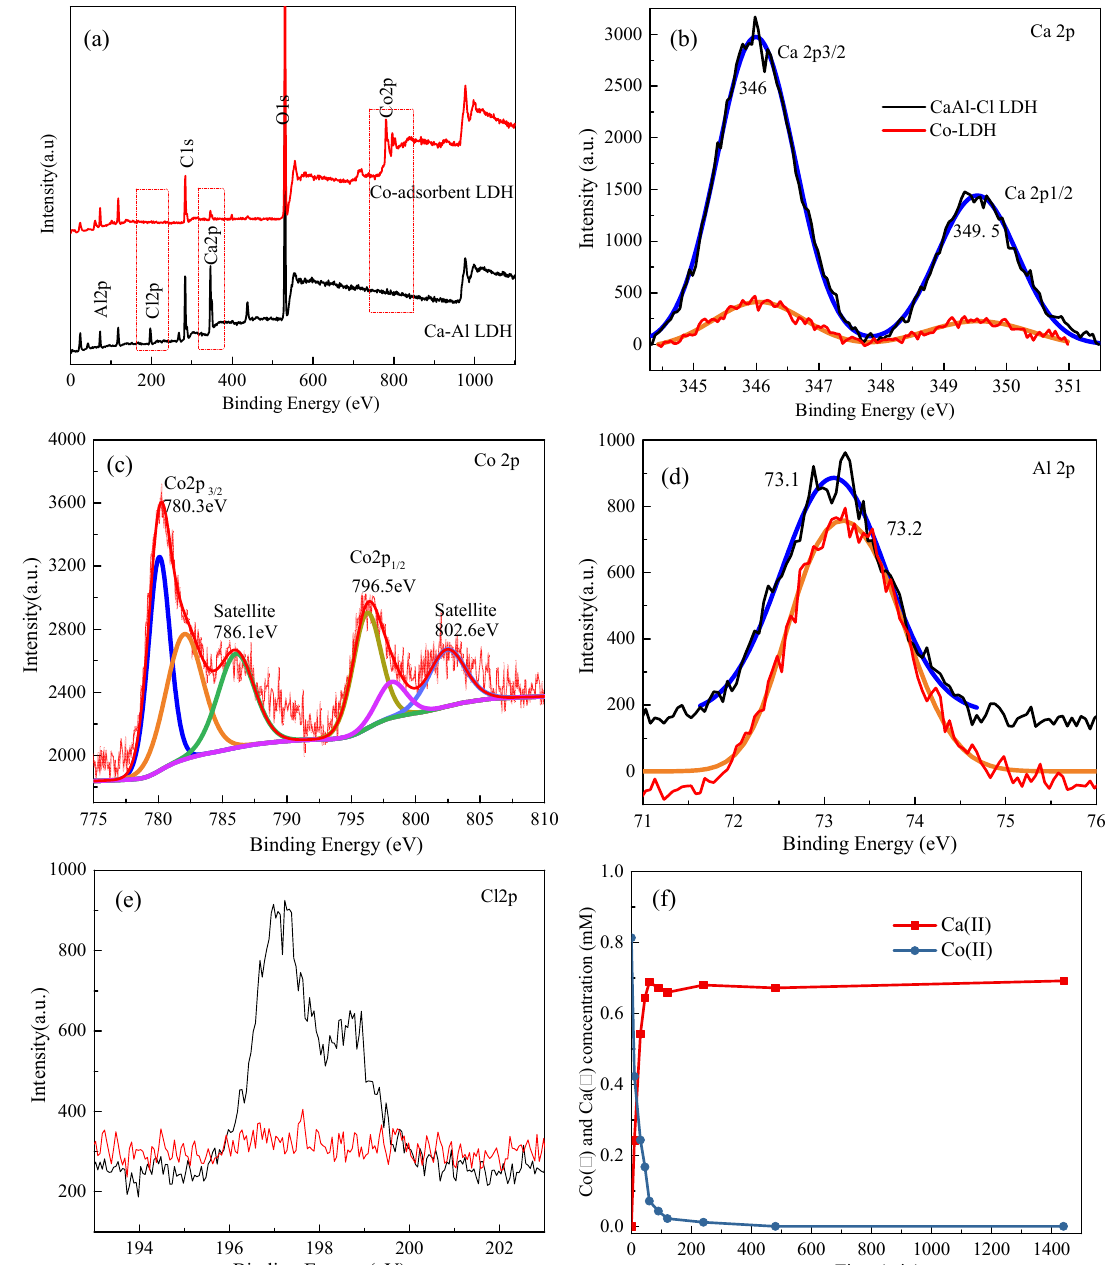
Figure 6. X‐ray photoelectron spectroscopy (XPS) spectra survey of the CaAl‐Cl‐LDH before (black line) and after (red line) cobalt adsorption ( a ). The Ca 2p ( b ), Co 2p ( c ), Al 2p ( d ) and Cl 2p ( e ) spectra before and after cobalt adsorption. ( f ) The concentrations of free ionic Ca(II) and Co(II) in the solution during the removal of Co(II) with CaAl‐Cl‐LDH.